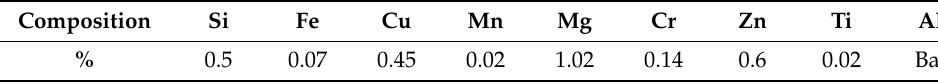
Table 1. Elemental composition of the base metal.